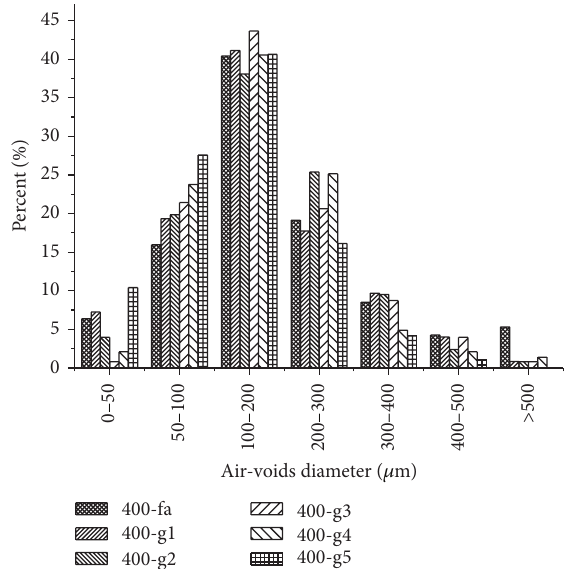
Figure 7: Effects of GHBs on air-voids diameter distribution of the test specimens.